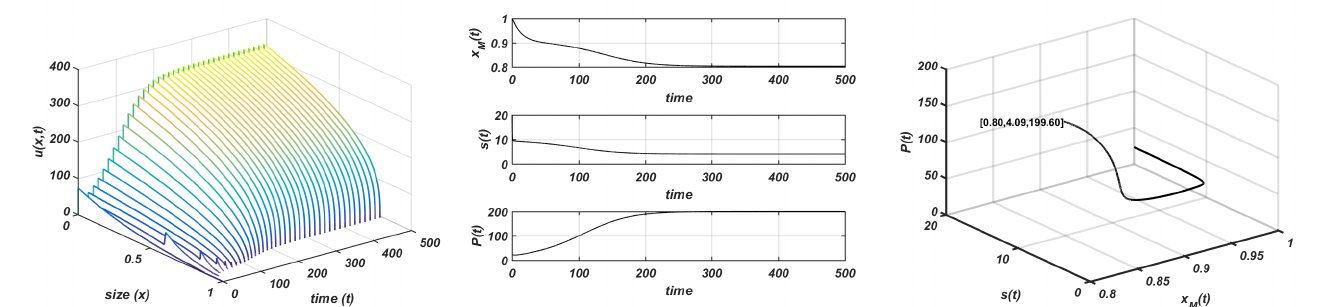
Figure 4. Chemostat growth. r = 4.5, K = 10, and s 0 = 20. Stable equilibria. Plot on the left : evolution of the structure of the consumer; plot in the centre : evolution of the maximum size, resource, and total consumer population to the equilibrium; plot on the right : orbit followed towards the equilibrium ( 0.80,4.09,199.60 ) .